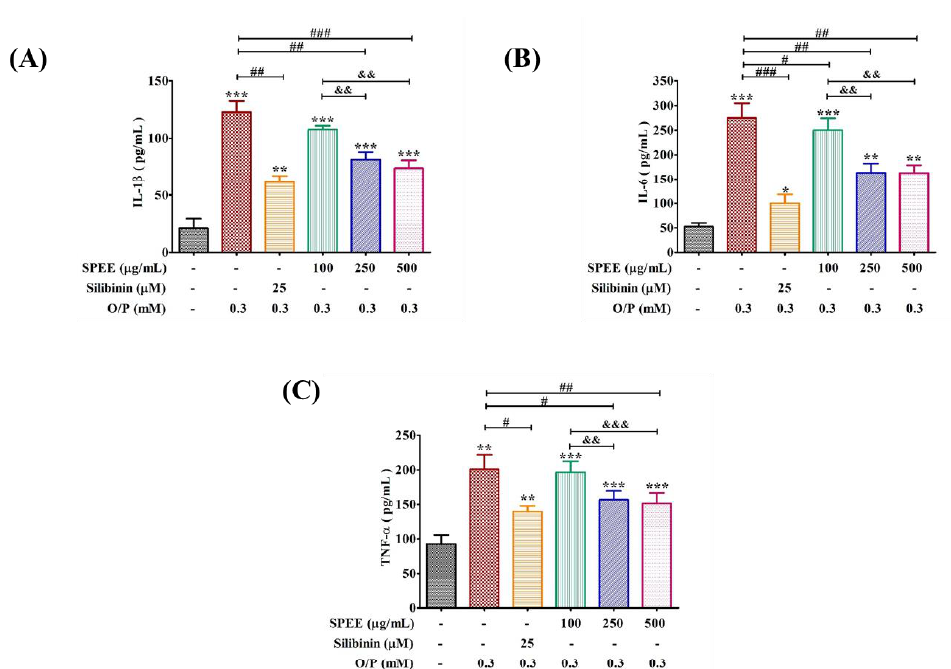
Figure 7. The effects of SPEE on O/P-induced intracellular inflammatory factors in HepG2 cells. HepG2 cell lines were co-treated with 0.3 mM O/P and SPEE (100, 250 and 500 μ g/mL, respectively) for 24 h. The expression of pro-inflammatory factors (TNF- α , IL-6 and IL-1 β ) was analyzed as described in Materials and Methods. Silibinin was used as the positive control. Data are expressed as mean ± SD from triplicate experiments. * p < 0.05, ** p < 0.01 and *** p < 0.001 vs. the control group. # p < 0.05, ## P < 0.01 and ### p < 0.001 vs. the O/P group. && p < 0.01 and &&& p < 0.001 vs. the O/P 0.3 mM + SPEE 100 μ g/mL group.